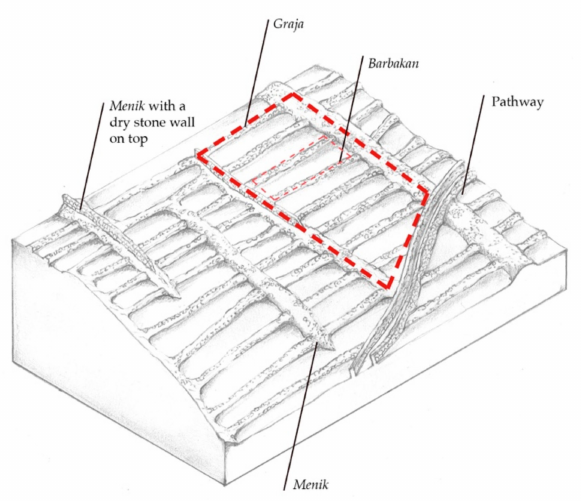
Figure 30. Main components of an agricultural plot within the Cres olive grove named graja (sketch author: Anita